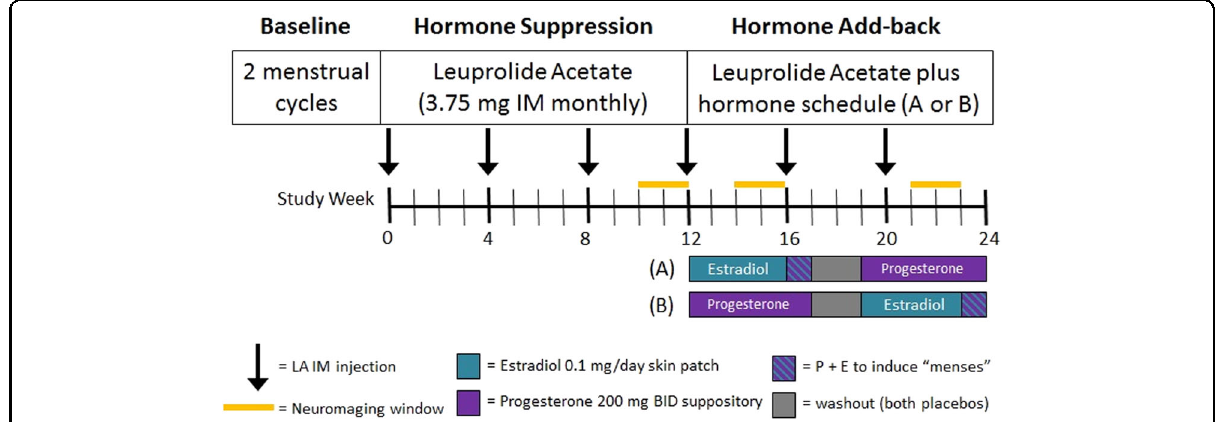
Fig. 1 Schematic diagram of GnRH agonist-induced Hypogonadism and Gonadal Steroid Replacement. Following a two-month baseline evaluation period, women received 3.75 mg of Lupron (leuprolide acetate, purchased from TAP Pharmaceuticals, Chicago, IL) by intramuscular injection every four weeks for six months. Lupron alone was administered for the fi rst 12 weeks. After the Lupron-alone period, women received, in addition to Lupron, 17 β estradiol (0.1 mg/day) by skin patch or progesterone suppositories (200 mg BID) for fi ve weeks each. Women then were crossed – over to the alternative treatment (in a double-blind, counterbalanced design). During the fi fth week of estradiol add-back, progesterone suppositories (200mg twice daily) were added to provide progesterone withdrawal-induced shedding of the endometrium and menses in order to prevent prolonged exposure of the endometrium to unopposed estrogen. The two replacement regimens were separated by a two-week washout period. Three PET sessions were acquired: during Lupron alone, estradiol add-back, and progesterone add-back periods. This experimental paradigm allowed us to compare brain function in the absence of ovarian steroids, as well as during the separate administration of estradiol or